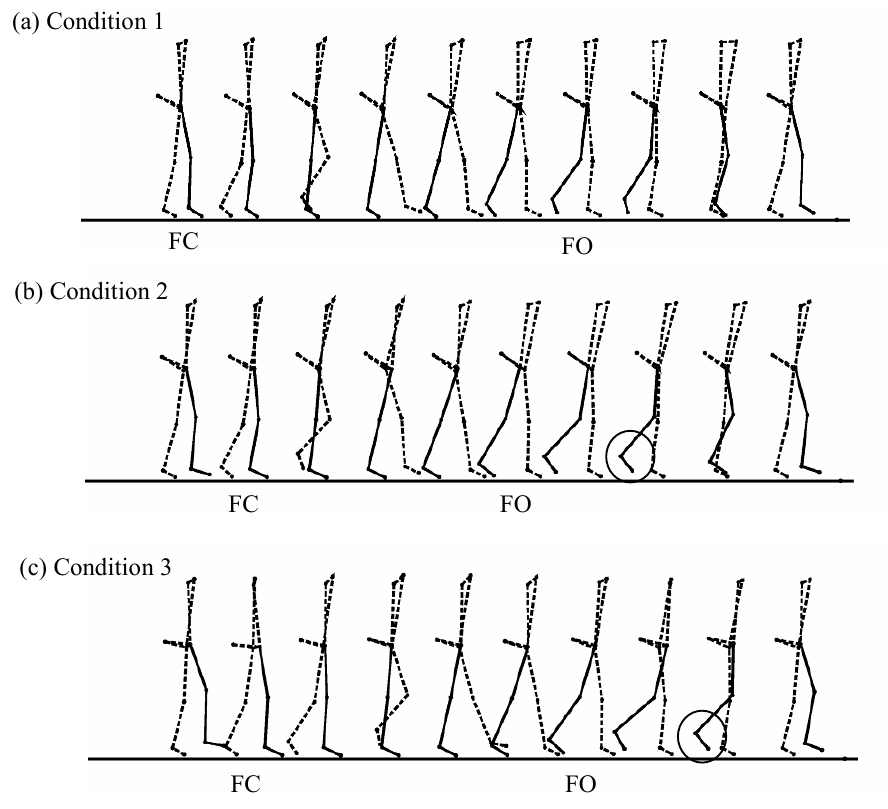
Fig. 6 Stick figures illustrating one gait cycle beginning with affected-side foot contact under each condition. Solid lines show the affected limb and broken lines indicate the rest of the body. FC and FO denote foot contact and foot off, respectively. For each cycle, ten illustrations are shown, with each offset for